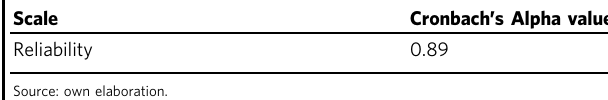
Table 2 Evaluation table instrument. Table 3 Cronbach ’ s Alpha validation